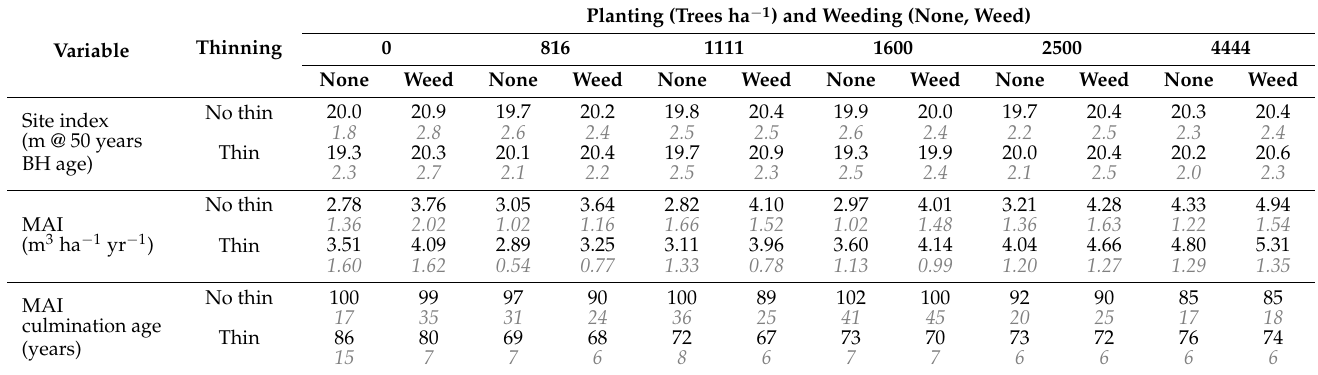
Table 5. Projected productivity variables: means and standard deviations.